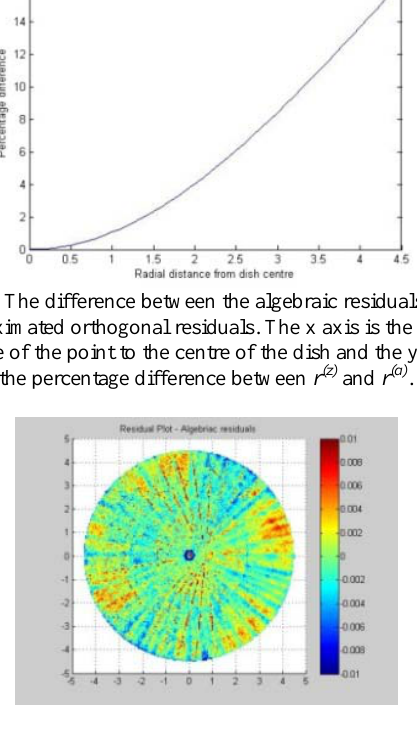
Figure 5: Residual map of the fitted dish using algebraic residuals with a RMS of 0.0031m. The axes represent the local x and y coordinate system of the dish, with the bottom of the dish (closest to the ground) towards the right of the figure.